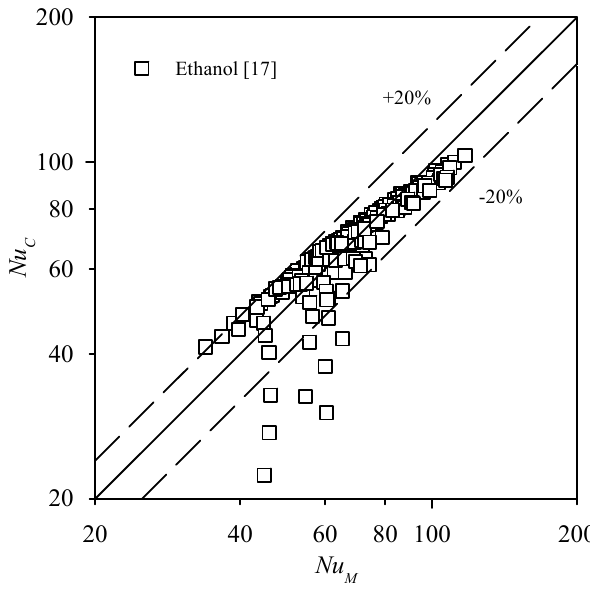
Table 10. The predictive ability of the proposed correlation for heat transfer coefficient of supercritical organic fluids.